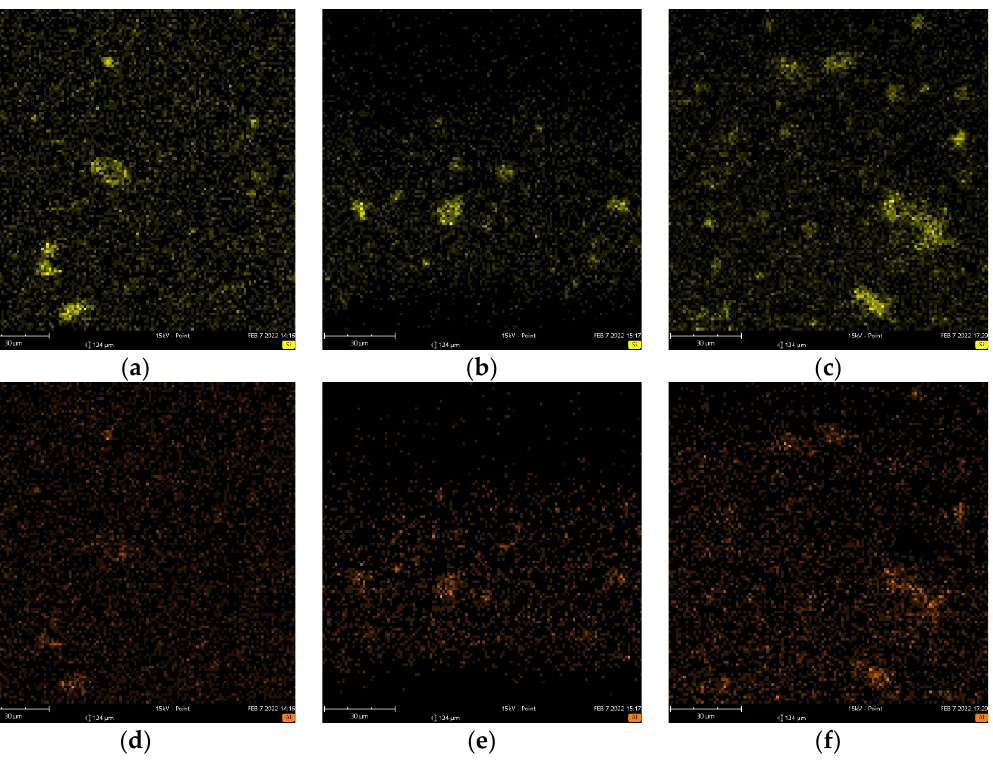
Figure 3. EDX color-mapping for ( a ) PLA/MM Τ 1, ( b ) PLA/MMT2, ( c ) PLA/MMT4 showing the presence of Silicon (Si-yellow) and ( d ) PLA/MM Τ 1, ( e ) PLA/MMT2, ( f ) PLA/MMT4 showing the presence of Aluminum (Al-orange).